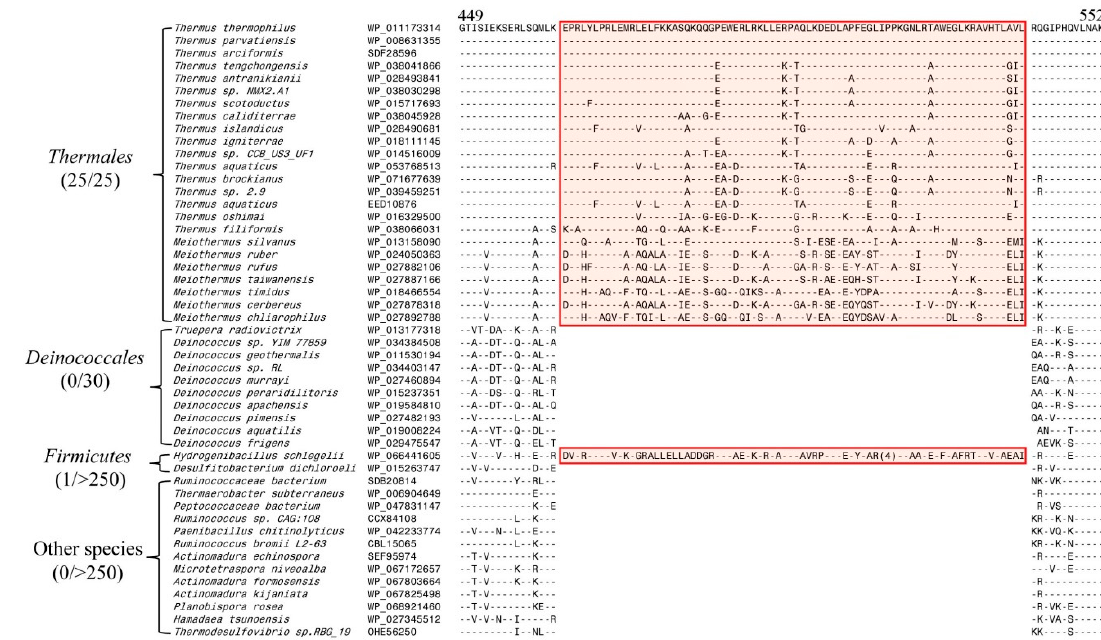
Figure 2. Partial sequence alignment of SecA showing a 76 aa conserved insert that is a unique characteristic of species from the order Thermales and H. schlegelii but absent from the SecA homologs from all other bacteria. Except for H. schlegelii , no other Firmicutes species contained this insert. Other information concerning this sequence alignment is the same as in Figure 1.